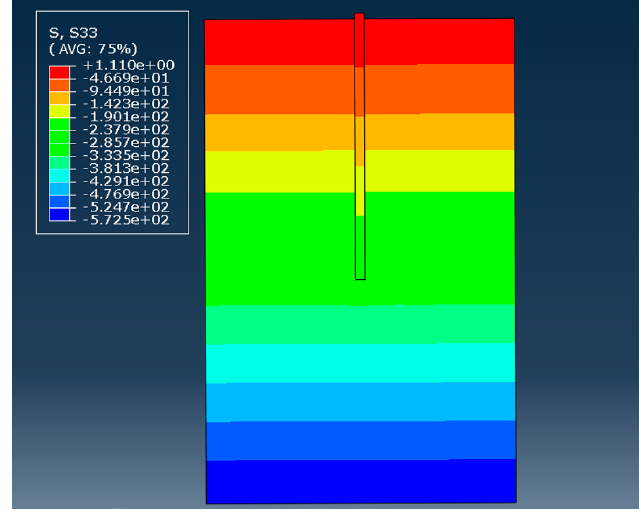
Figure 11. Vertical stress nephogram of soil after stress equilibrium.